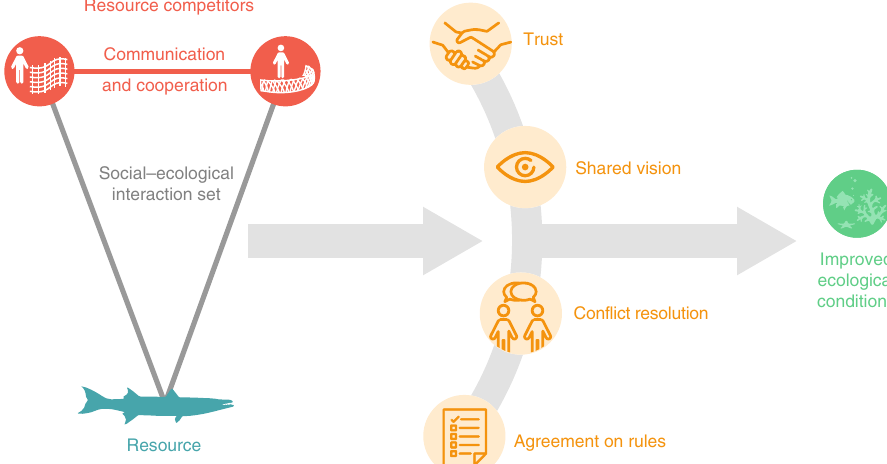
Fig. 2 Theoretical mechanisms linking social – ecological network closure and ecological conditions. A conceptual diagram illustrating key social processes theoretically supported by social – ecological network closure that may lead to improved ecological conditions in the commons. When direct resource competitors in settings characterized by strong and complex patterns of social – ecological interactions form cooperative communication ties, it lays the foundation for the emergence of trust, a shared vision, and sustained commitments 27,29,30 regarding the management of shared resources. Two examples of such commitments include the development of con fl ict resolution mechanisms and agreement on rules. These social interactions and processes can ultimately lead to improved ecological conditions. It is important to note that this fi gure is only illustrative of key mechanisms linking social – ecological network closure to ecological conditions and does not include the full range of social – ecological interactions and feedbacks that can affect both ecological and social conditions in any given environmental